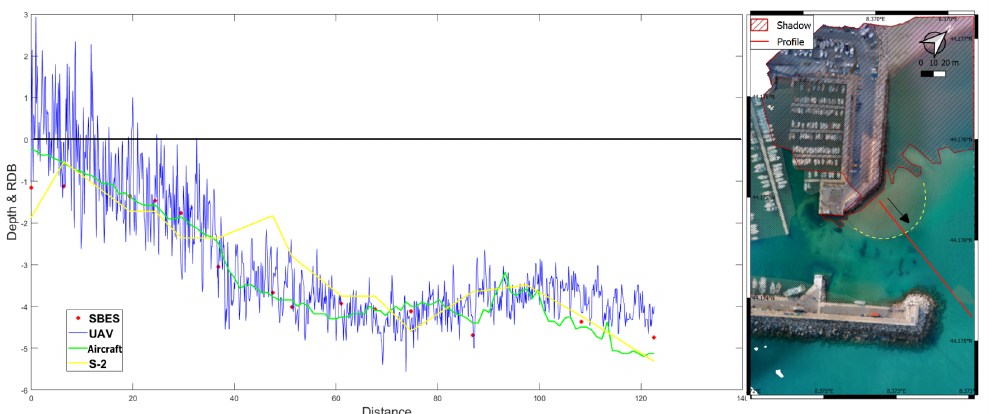
Figure 20. Comparison between SBES and RDBs for the three platforms along a transect (in the red line on the orthophoto on the right) in Capo San Donato. A sand bar is contoured with a dashed yellow line.